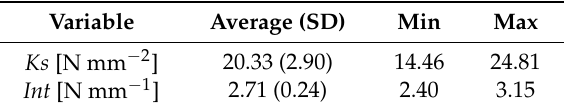
Figure 10. Specific cutting coefficient ( Ks ) and intercept when machining PTFE: ( a ) with 0.3, 0.7, 1.1 and 1.5 mm of depth of cut computed at 90° grain orientation; ( b ) gathered for every 10°-grain orientation. Table 2. Average specific cutting coefficient ( Ks ) and intercept values computed when machining PTFE with the up-milling technique.